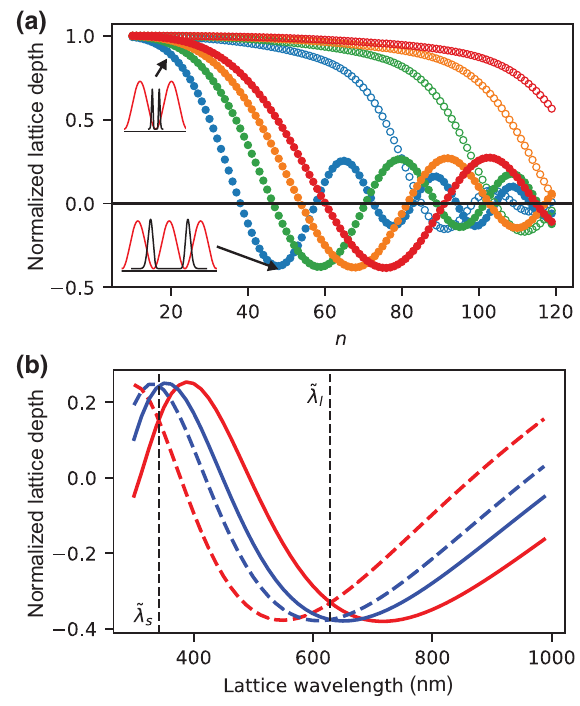
FIG. 3. Ponderomotive optical lattices. (a) Normalized lattice- depth [integral in Eq. (2)] as a function of n , for an in-plane (filled circles) or ˆ z -oriented (open circles) lattice. The colors denote dif- ferent wave vectors | k | = 2 π/λ with λ = ( 400, 600, 800, 1000 ) nm, shown in (blue, green, orange, red). The insets show the con- figuration of the Rydberg wave function (black) with respect to the lattice (red) for the stable trap position at the n indicated. (b) Ponderomotive lattice depth for the four computational states as a function of wavelength, highlighting two wavelengths where the storage and active states have nearly identical trap